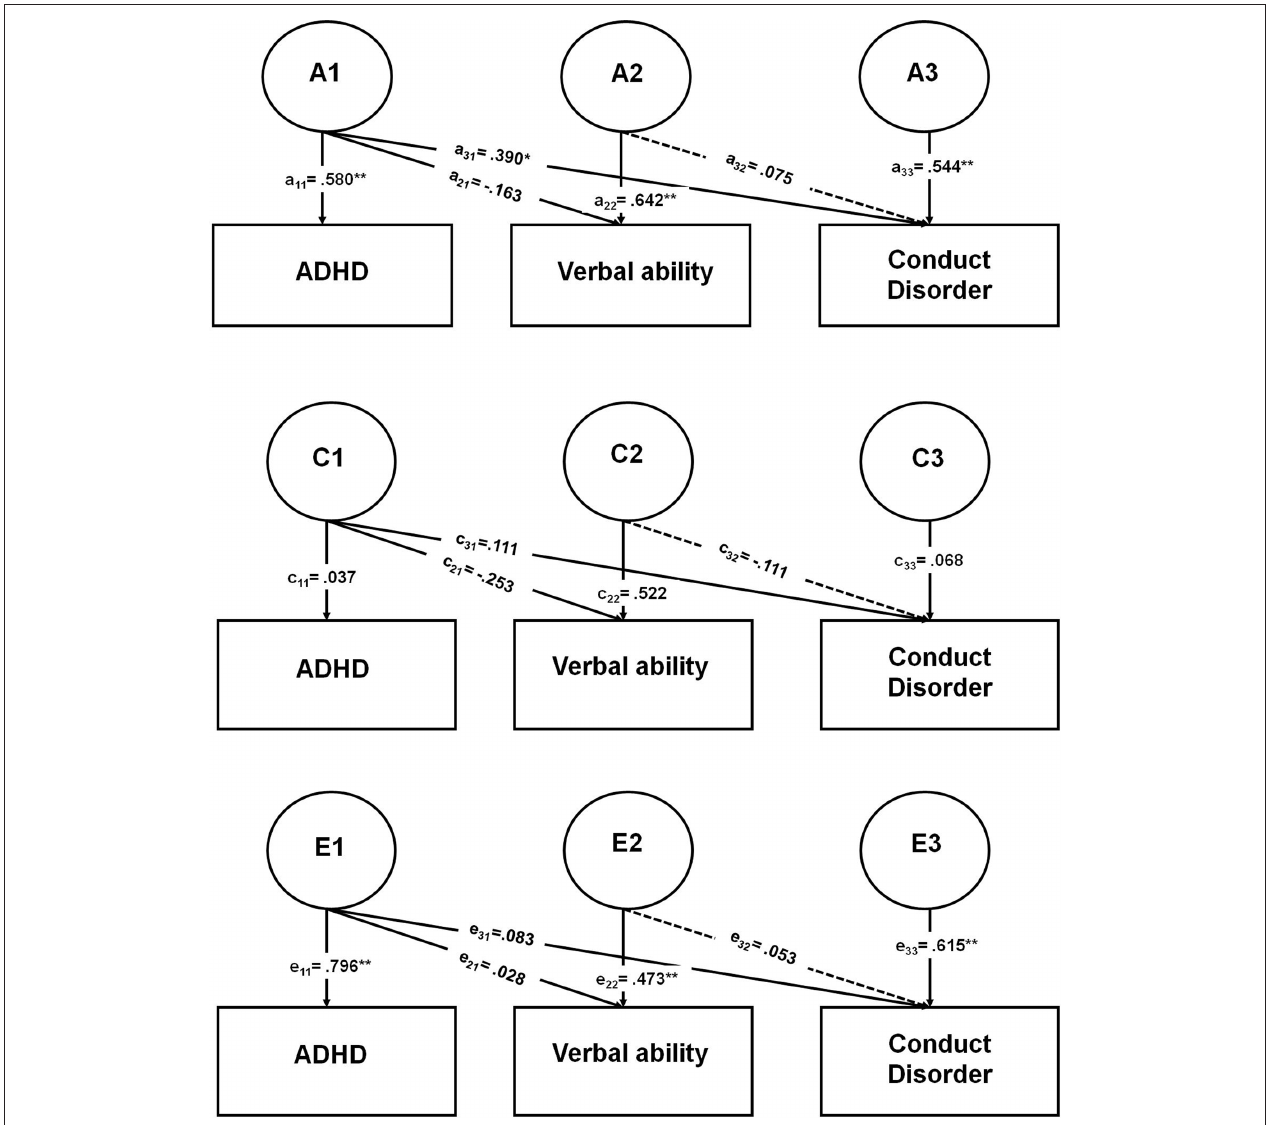
environmental influences shared in common by ADHD, verbal ability, and CD. C2 = Shared environmental influences shared in common by verbal ability and CD. C3 = Shared environmental influences specific to CD. E1 = Non-shared environmental influences shared in common by ADHD, verbal ability, and CD. E2 = Non-shared environmental influences shared in common by verbal ability and CD. E3 = Non-shared environmental influences specific to